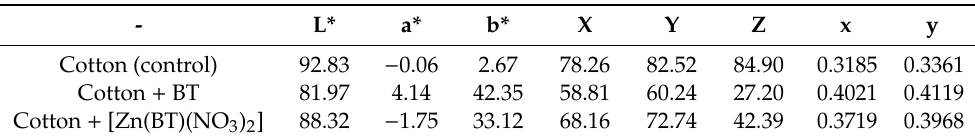
Colour characteristics of non-treated cotton fabrics and those treated with BT and [Zn(BT)(NO 3 ) 2